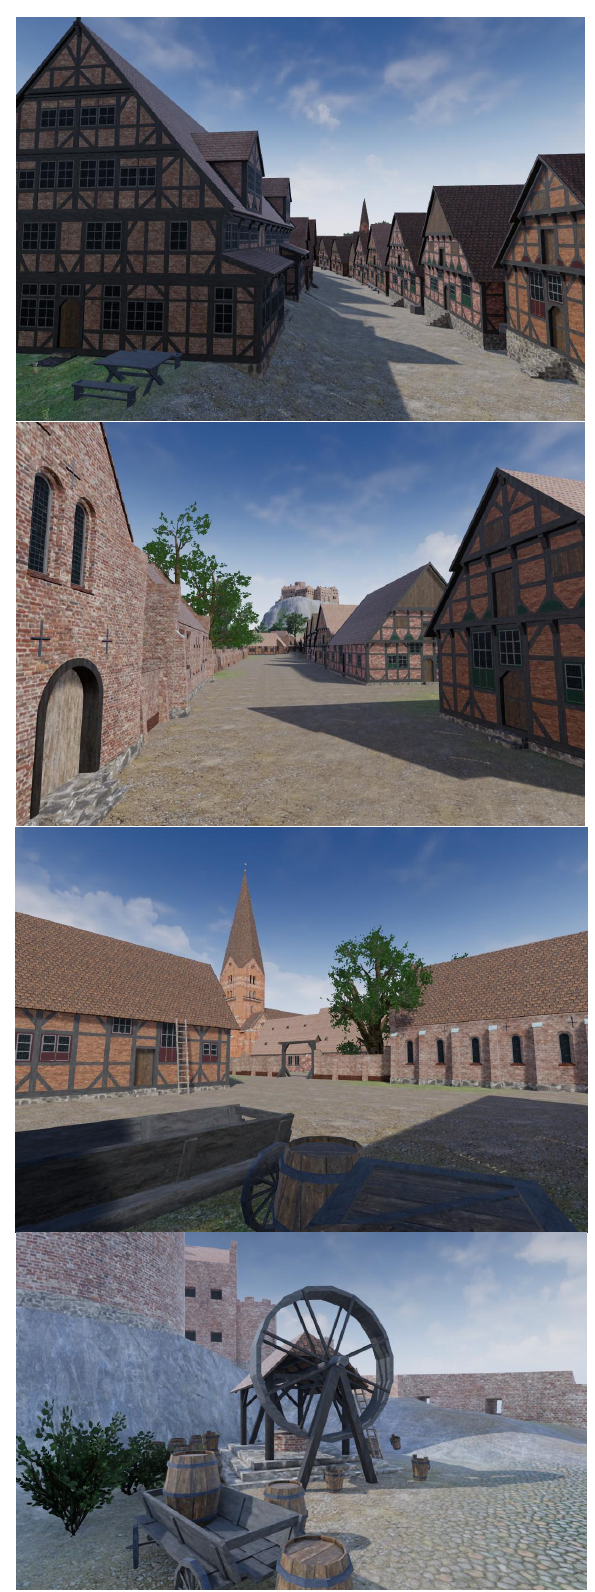
Figure 11. Impressions of the historic life in Segeberg and Gieschenhagen in the year 1600 – from top to bottom: